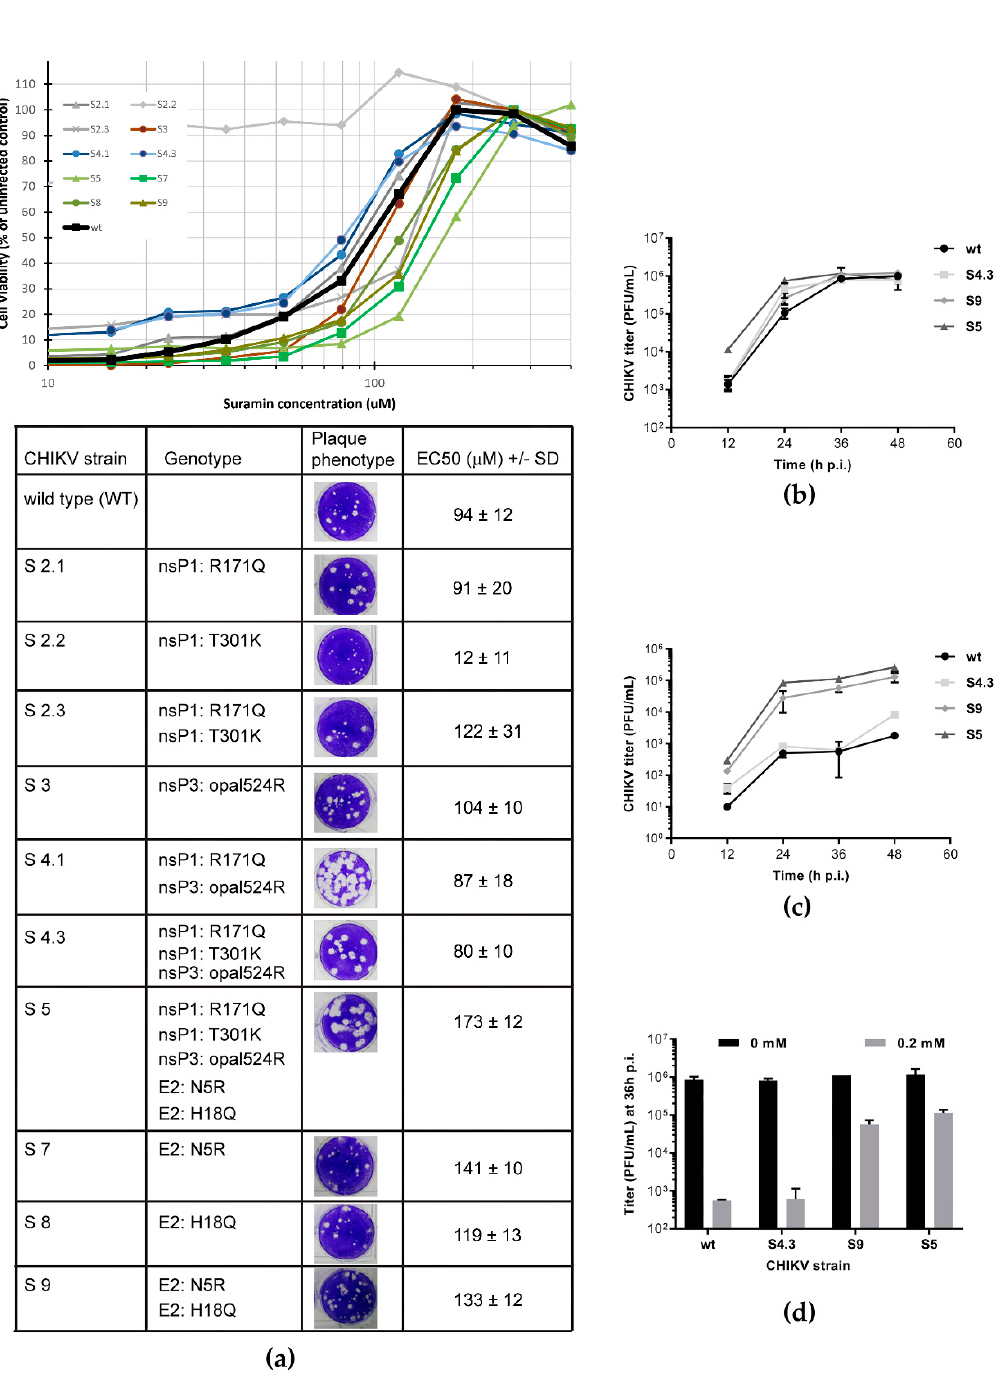
Figure 2. Characterization and suramin sensitivity of reverse engineered CHIKV variants ( a ) Mutations identified in suramin-resistant CHIKV mutants (Table 1) were reverse-engineered (individually or in combinations) into infectious cDNA clone CHIKV LS3. Plaque morphology (in the absence of suramin) and EC 50 (mean, n = 8) for suramin as determined by CPE reduction assay (curves in graph above table) are shown for each of the recombinant viruses. The values were determined from two independent experiments performed in quadruplicate. ( b , c ) Replication kinetics of CHIKV mutants S4, S5, S9 and wt virus were compared during infection of Vero E6 cells in the absence ( b ) or presence of 0.2 mM suramin ( c ). At several time-points p.i., culture supernatants were harvested and infectious virus titers were determined by plaque assay ( n = 2). ( d ) Side-by-side comparison of the 36 h p.i. titers of various mutants and wt virus grown in the absence (N.T., not treated) or presence of 0.2 mM suramin ( n = 2). All experiments were performed in Vero E6 cells and the data represent mean ± the SD.